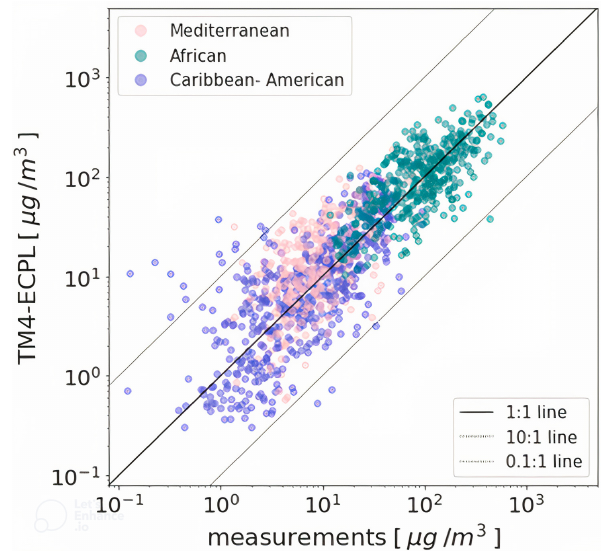
Figure 2. Monthly averaged model-simulated versus observed dust concentrations at the selected locations in µgm − 3 . The continu- ous black line is the 1 : 1 line, while the dashed lines are the 10 : 1 and 1 : 10, top and bottom lines, respectively. The stations are ge- ographically grouped: African stations in green (M’bour, Bambey, Cinzana, Banizoumbou), American stations in violet (Miami, Bar- bados, Cayenne), and Mediterranean stations in pink (Agia Marina and Finokalia). Simulations were run with a 3 ◦ × 2 ◦ spatial resolu-